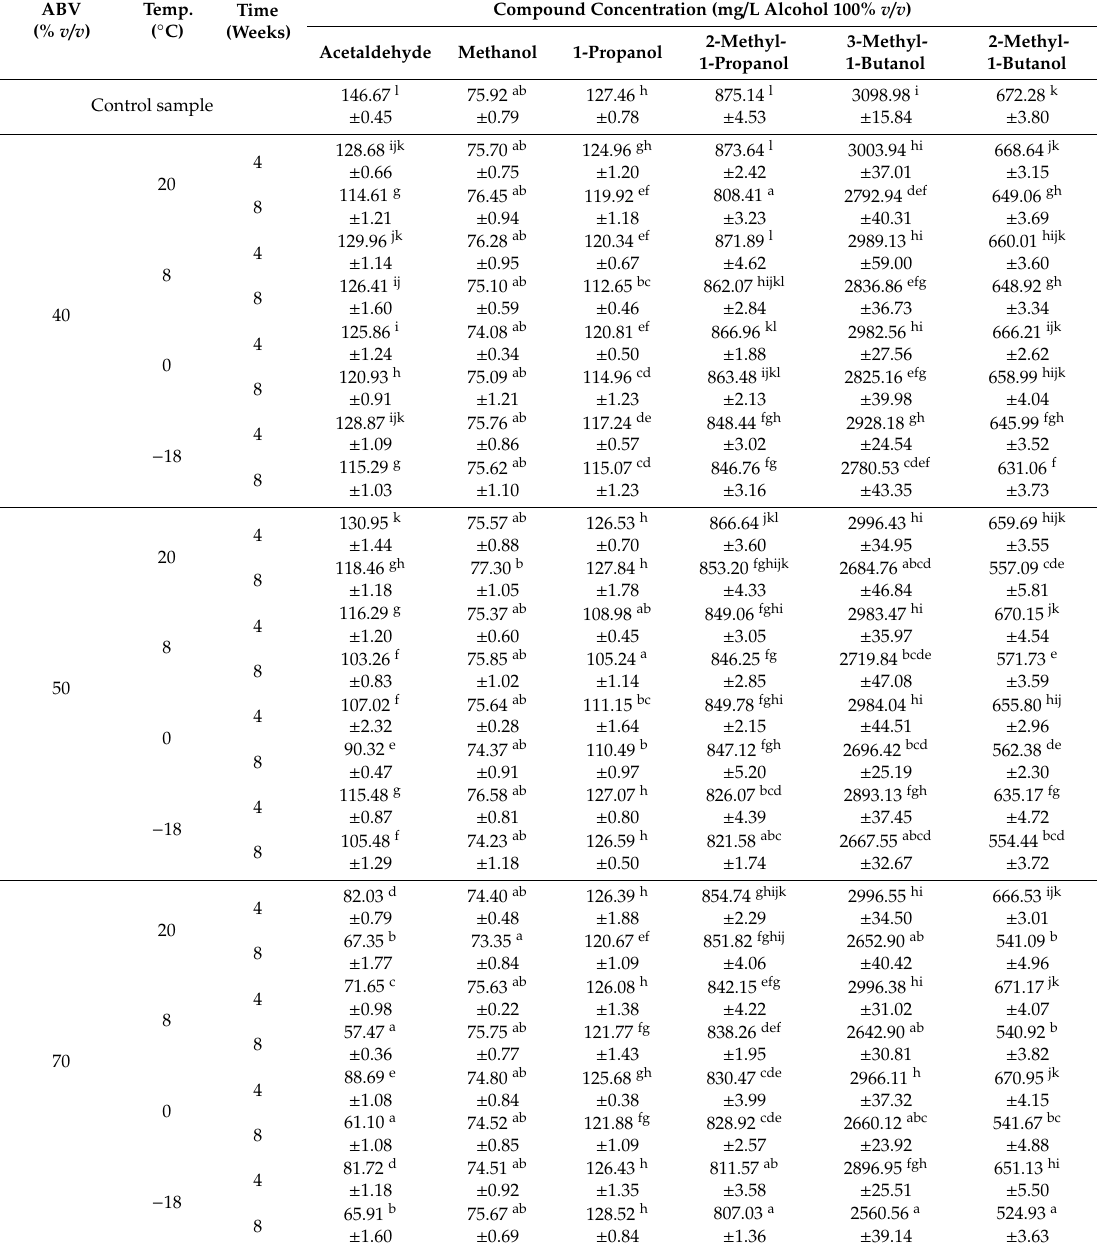
Table 3. Changes in aldehydes and alcohols in plum distillate samples during storage at di ff erent temperatures. ABV Temp. (% v / v ) ( ◦